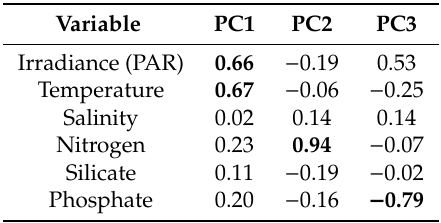
Table 1. Loadings of the environmental variables on the three leading principal components accounting for 76% of variation in presence-absence trait values across species. Bold numbers highlight the variables that dominate each principal